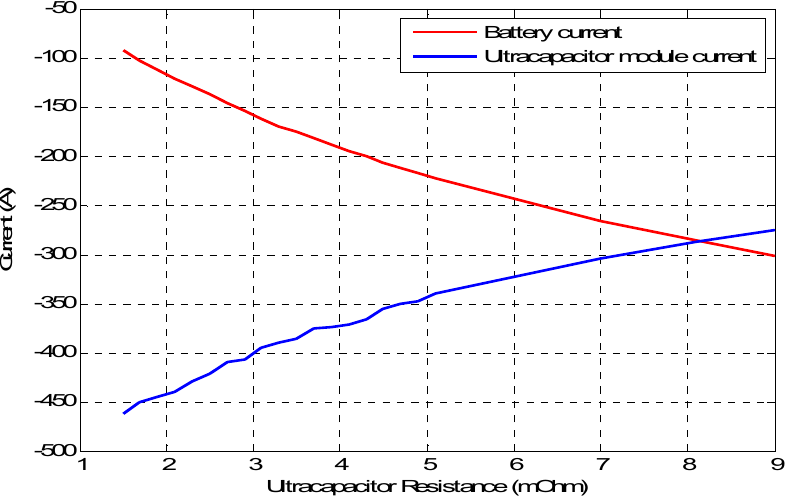
Figure 10. Cranking current sharing as a function of battery branch resistance.